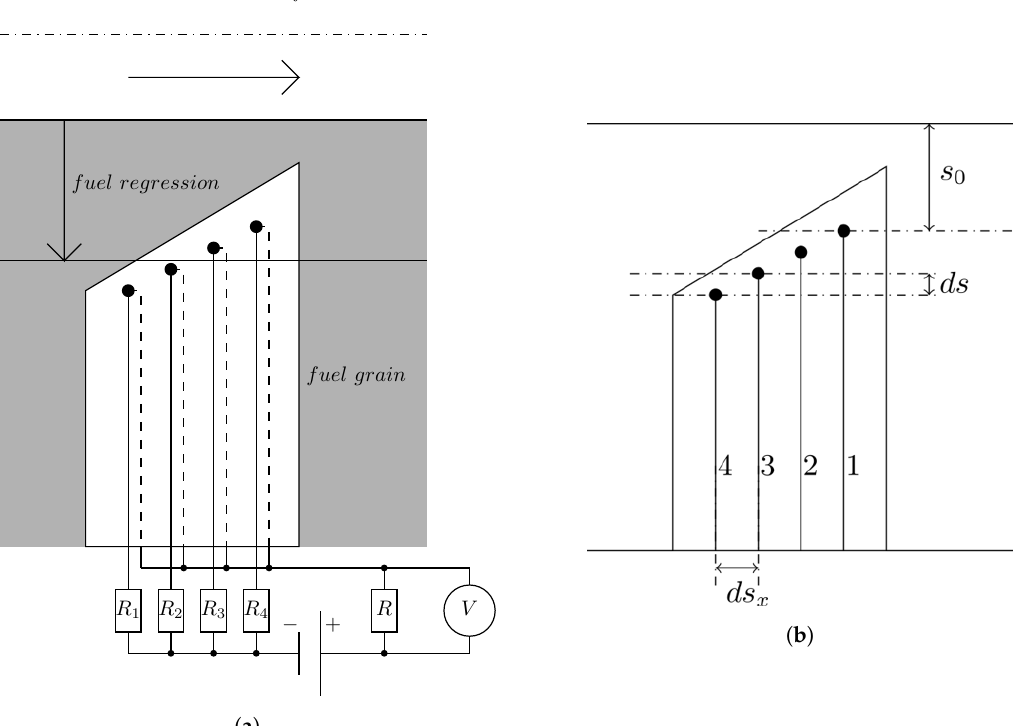
Figure 4. ( a ) resistor-based sensor principle and ( b )